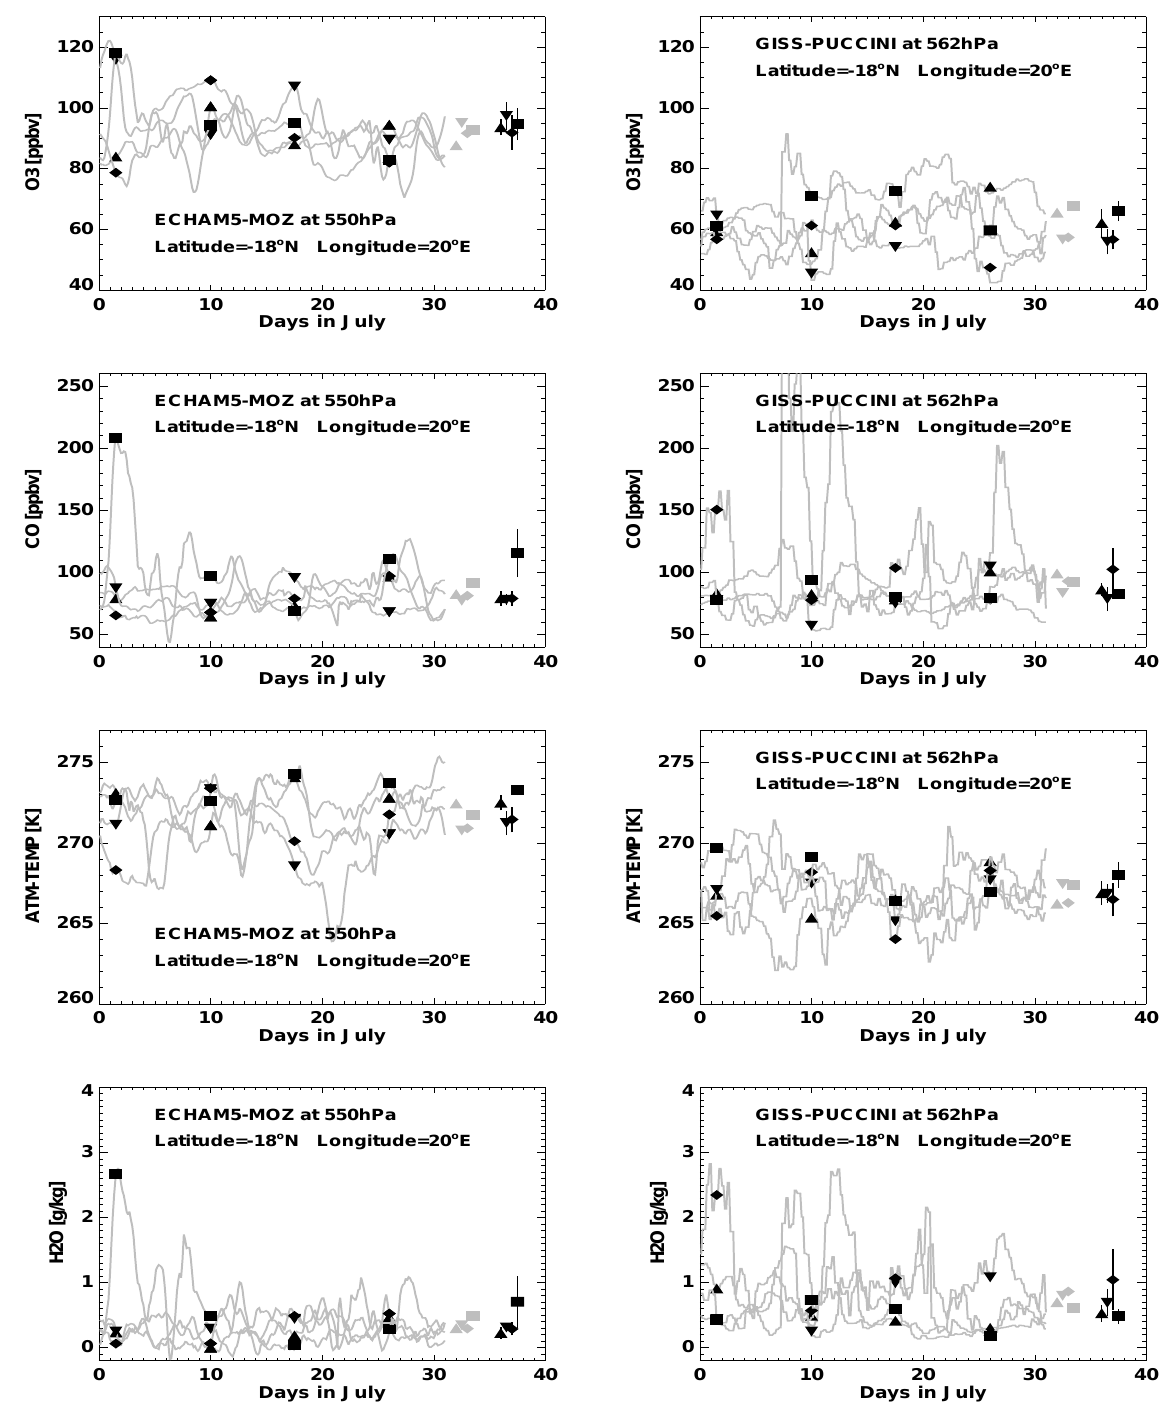
Fig. 3. The time-series of model output at longitude 20 ◦ E and latitude 18 ◦ S in July 2005–2008 (grey lines). The points sampled along the model time-series using TES spatio-temporal information is shown in Black symbols (diamonds, triangle, inverted triangle and squares) for each respective year. The ECHAM5-MOZ and the GISS-PUCCINI models are shown on the left and the right columns respectively. The grey and the black symbols shown on the far right of the plot are the mean of original time-series (grey) and the sampled points (black). On each of the mean values, we show the standard error of the mean as defined in Eqs. (9) and (10) for sampled and raw model time-series